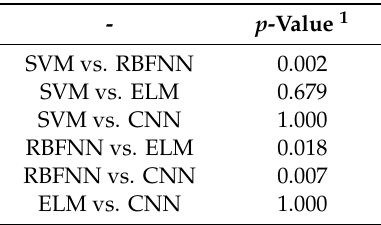
Table 5. Chi-square test for the prediction results of support vector machine (SVM), radial basis function neural network (RBFNN), extreme learning machine (ELM), and convolutional neural network (CNN) models on the full